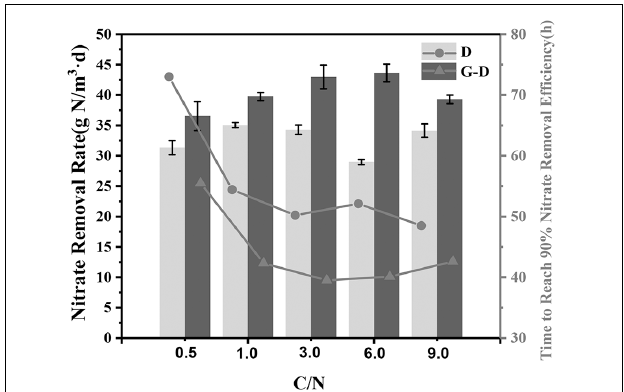
FIGURE 4 | Nitrate removal rate under different C/N ratios (0.5, 1, 3, 6, and 9) in Group D (denitrifying microbial community) and G-D ( G. sulfurreducens added denitrifying microbial community). The rate was calculated by fitting a straight line and taking the derivative for the variations of nitrate removal efficiency. The lines represent the time required to reach 90% nitrate removal